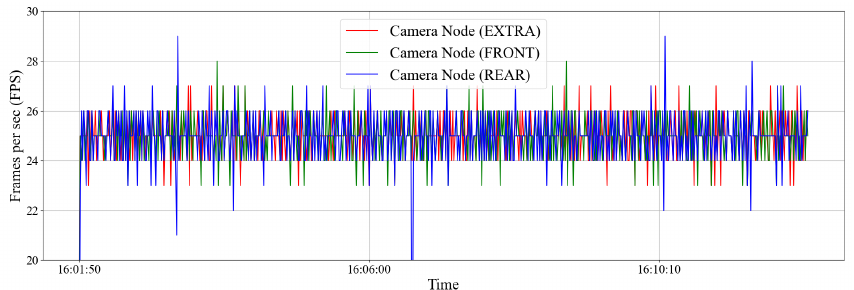
Figure 16. Density plot of the throughput of three camera nodes in an intra-vehicle environment over 10 min.